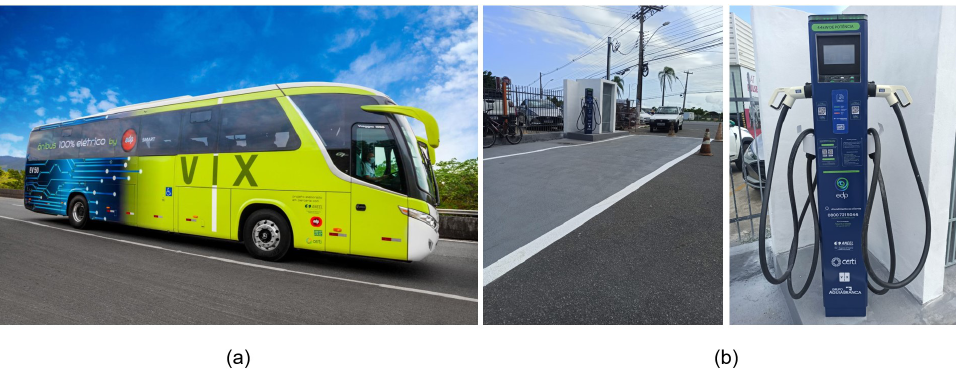
Figure 3. ( a ) Electric bus. ( b ) Charging